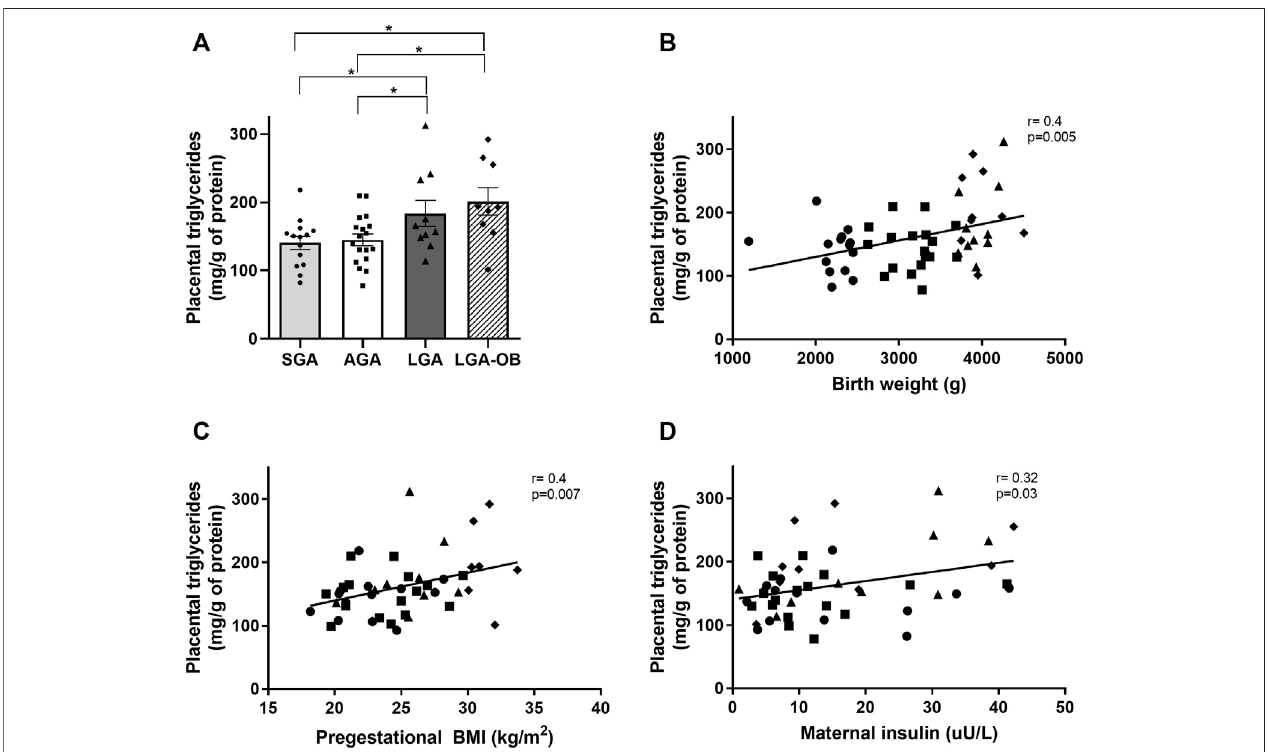
FIGURE4| TriglyceridecontentinplacentasofSGA,AGA,LGA,andLGA-OBnewbornsandcorrelationwithneonatalandmaternalvariables. (A) Quanti fi cationof triglyceridesinplacentasofSGA(n=14),AGA(n=18),LGA(n=10), andLGA-OB(n=9)newbornsbyenzymatic-colorimetric method. Resultswerenormalized tototal protein in each sample. * denotes signi fi cant difference ( p < 0.05) between groups by ANOVA. Correlation between placental triglycerides with birth weight (B) , pregestational BMI (C), and maternal insulin (D)